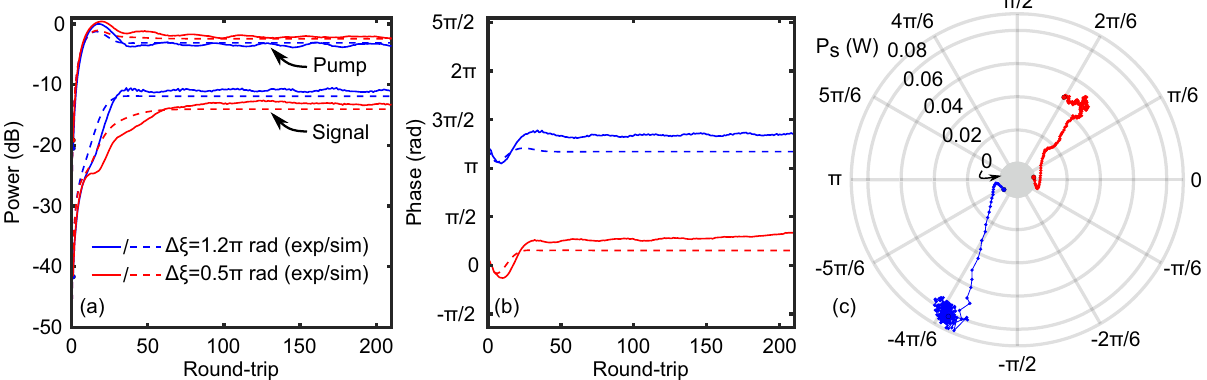
Fig. 4 Phase and intensity evolutions round-trip to round-trip. a Intra-cavity power of signal and pump wave versus the number of round-trip. b Relative intra-cavity phase between pump and signal versus the number of round-trip. c Phase plane ( P s (signal power), ϕ s − ϕ 0 (pump-signal signal phase difference)). The solid and the dashed lines stand for the experiments and numerical simulations of the Lugiato − Lefever equation Eq. 4, respectively. Exp : experiments, Sim. : simulation and Δ ξ (relative